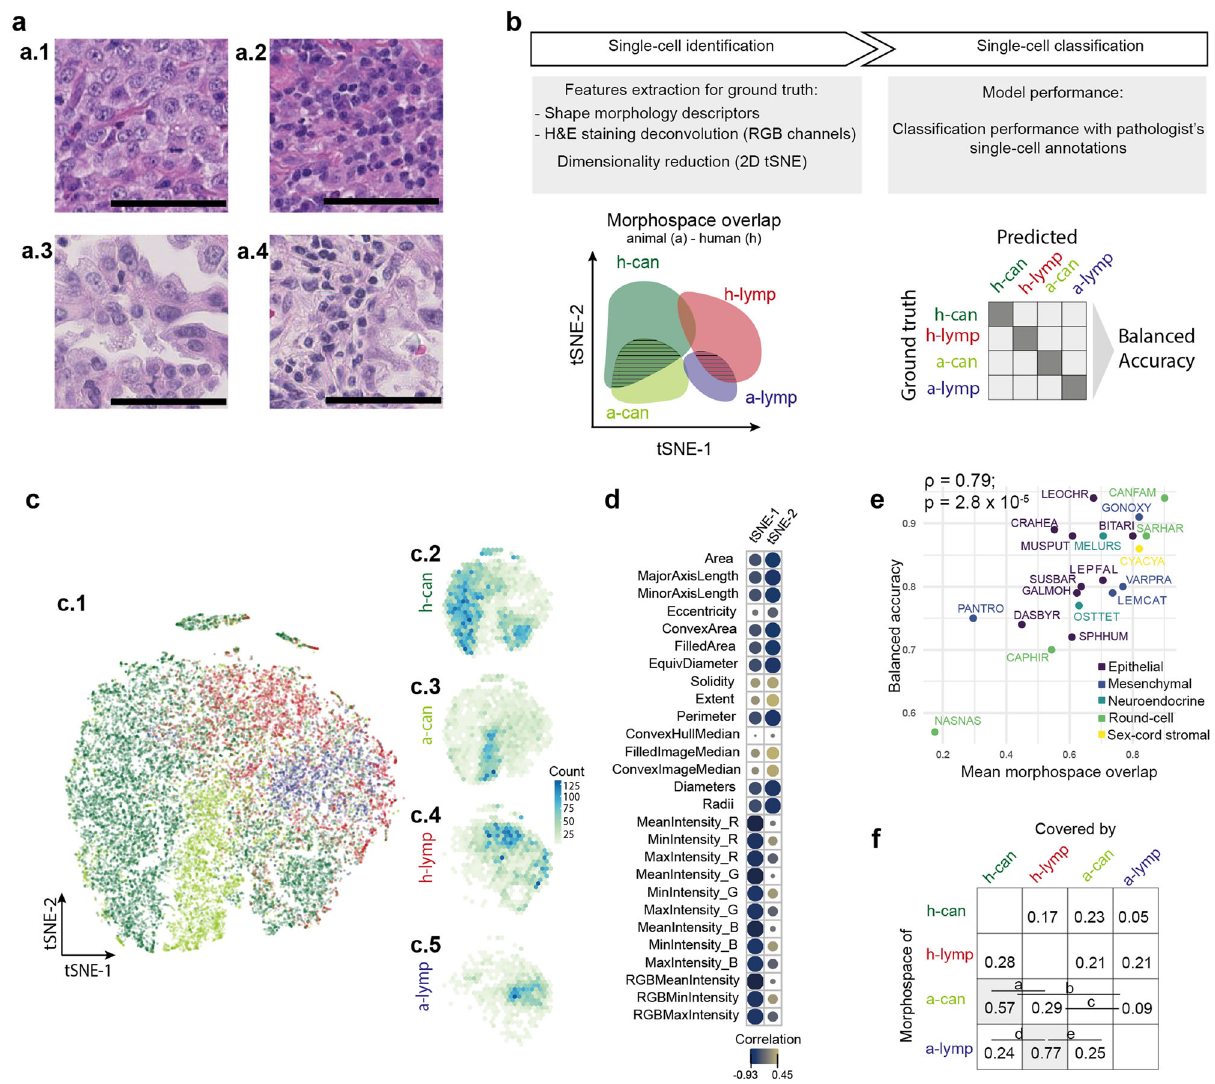
Fig. 4 | Overlap across the morphological space. a Canine ( a.1 , a.2 ) and human cells ( a.3, a.4 ) have visible morphological similarities even for non-speci fi c stainings suchashematoxylin andeosin across cancer cells ( a.1 , a.3 ) andimmune cells ( a.2 , a.4 ). Scale bar = 50 µ m. b Explanation of the morphospace overlap score based on feature extraction of single cells annotated by pathologists, human (h-) and animal (a-) cancer cells (can) and lymphocytes (lymp). c Dimensionality reduction enables the evaluation of morphospace overlap across human ( c.2 , c.3 ) and non-human cells ( c.4 , c.5 ). d The t-SNE dimensions show explainable cell features associated with staining and morphology (see